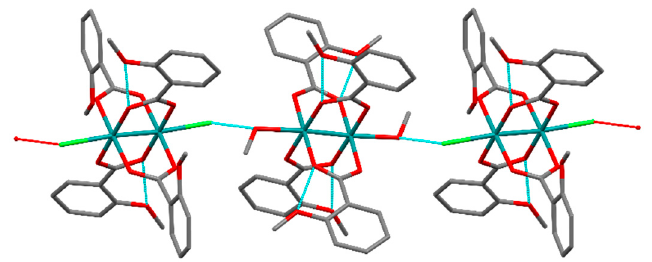
Figure 3. Drawing of a zigzag chain of 1c . Hydrogen atoms are omitted for clarity.